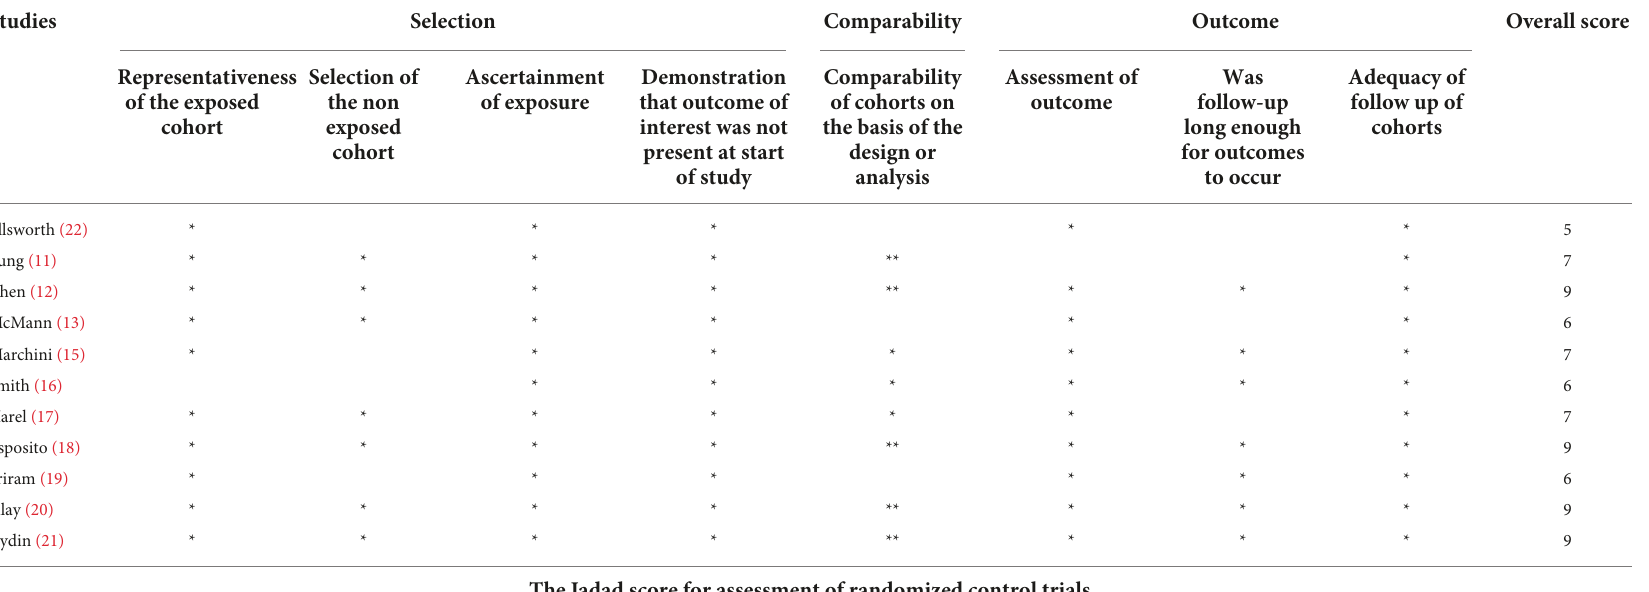
TABLE 2 Assessment of methodological quality of included